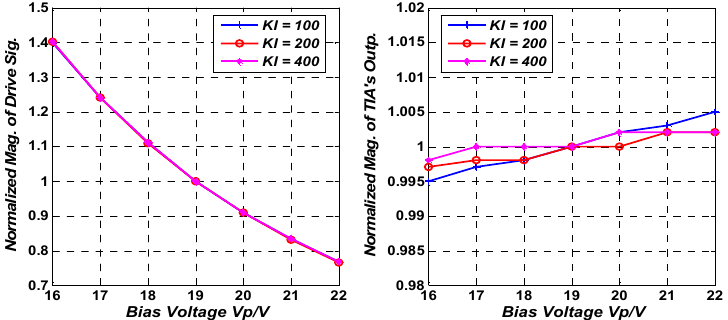
Figure 13. Normalized magnitude of drive signal and TIA’s output with different K varying V p